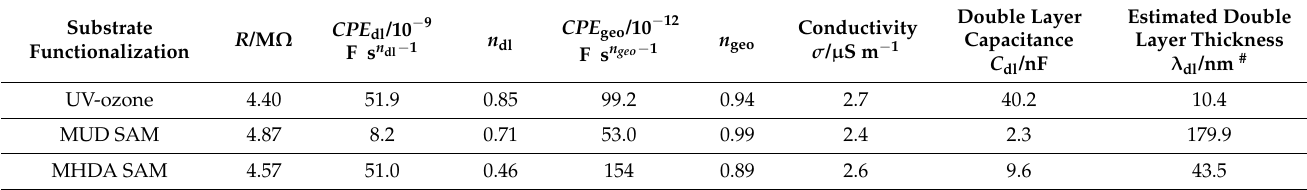
Figure 5. Nyquist plots of IL [BMIM][TFSI] in HKUST-1 SURMOF films. The SURMOF films are grown on the IDE substrates, whose surface has been treated in different ways before the SURMOF synthesis: One substrate has an OH-terminated MUD-SAM (green), one has a COOH-terminated MHDA-SAM (red) and one substrate was exposed to UV-ozone for 30 min before the SURMOF synthesis (blue). The black lines are the fits with the ( R-CPE dl ) (cid:107) CPE geo circuit, where the parameters are shown in Table 2. The substrates are glass sheets with IDEs of 10 µ m gap distance and a total gap length of 1.69 m. The area of each electrode is approximately 17 mm 2 . The frequency range is 3.5 Hz to 5 MHz. Table 2. The parameters determined from the EIS data in Figure 5. The HKUST-1 SURMOFs are prepared on the same kind of IDE-substrates but with different substrate functionalizations. The electrolyte is [BMIM][TFSI] ionic liquid with 50% pore filling. The thickness of the double layer is assessed by λ dl = ε r ε 0 A electrode / C dl . A value of 2.8 was used for the permittivity, ε r , which is the value for the empty HKUST-1 MOF [63]. Please note, the permittivity value of the MOF is actually somewhat larger, due to the IL pore fillings, increasing the calculated thickness of the double